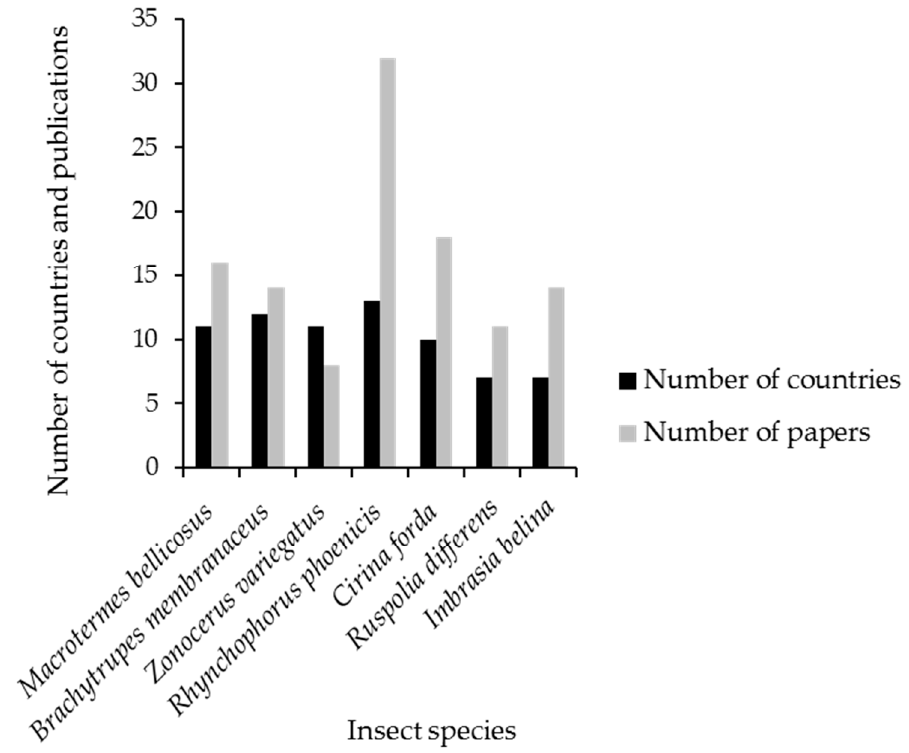
Figure 2. The number of countries with journal peer-reviewed articles published on the most consumed and economically important insects in